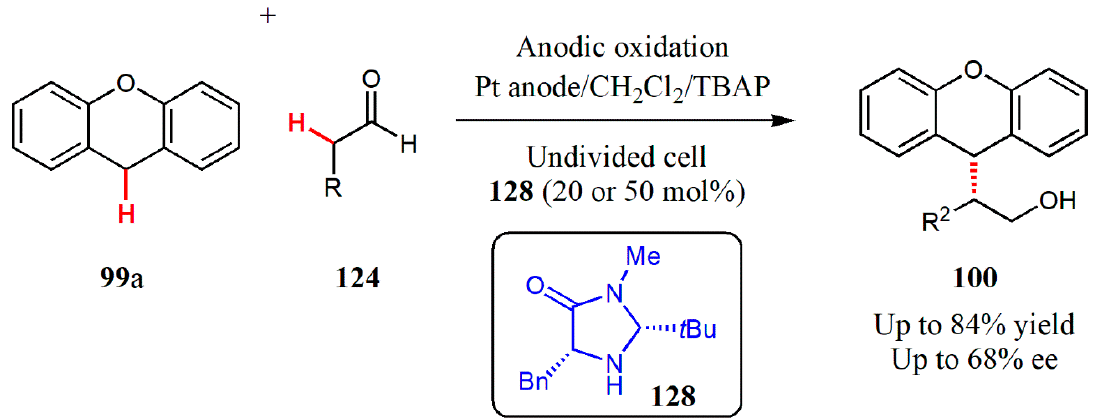
Figure 39. Electro-organocatalysis in the enantioselective CDC of xanthenes and aldehydes; TBAP = tetrabutylammonium perchlorate.